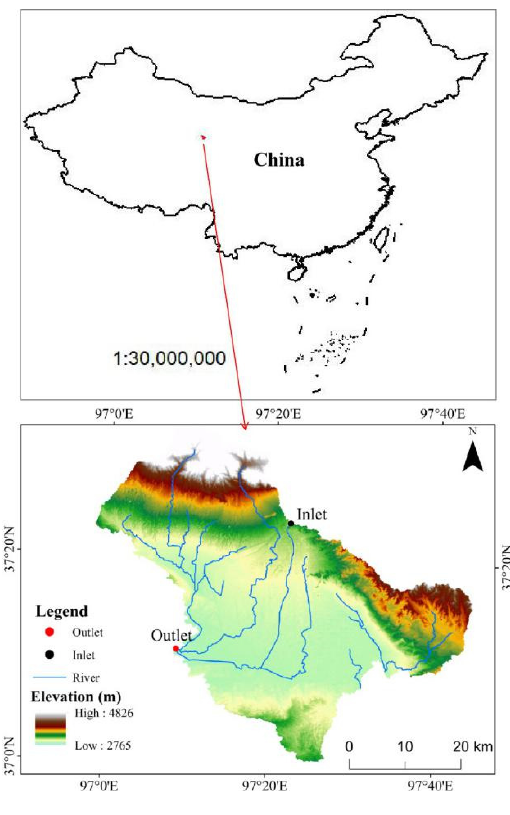
Figure 1. Study area.